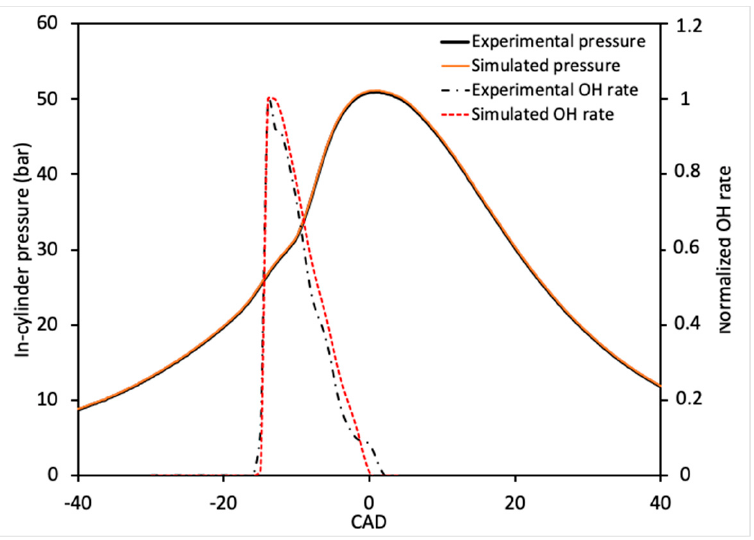
Figure 10. Experimental and numerical of OH radical rates comparison when the injection pressure is equal to 700 bar and engine speed fi xed at 1000 rpm.